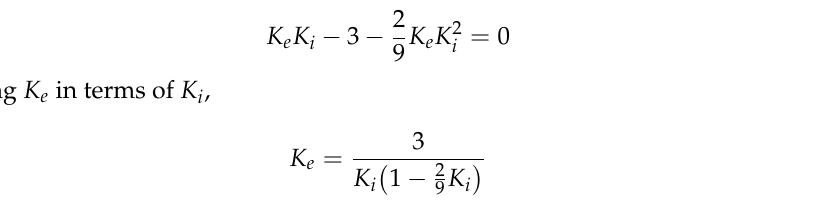
The plot of the phase margin, PM, versus K i for an ideal three-pole system designed with the constraint in (16) is shown in Figure 3. The point PM (cid:63) = 68.4 deg identifies the phase margin observed at the optimum bias point set by ( K (cid:63)